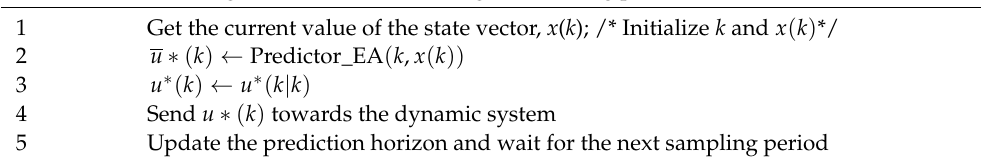
Algorithm 1 Receding Horizon Controller’s algorithm using predictions based on